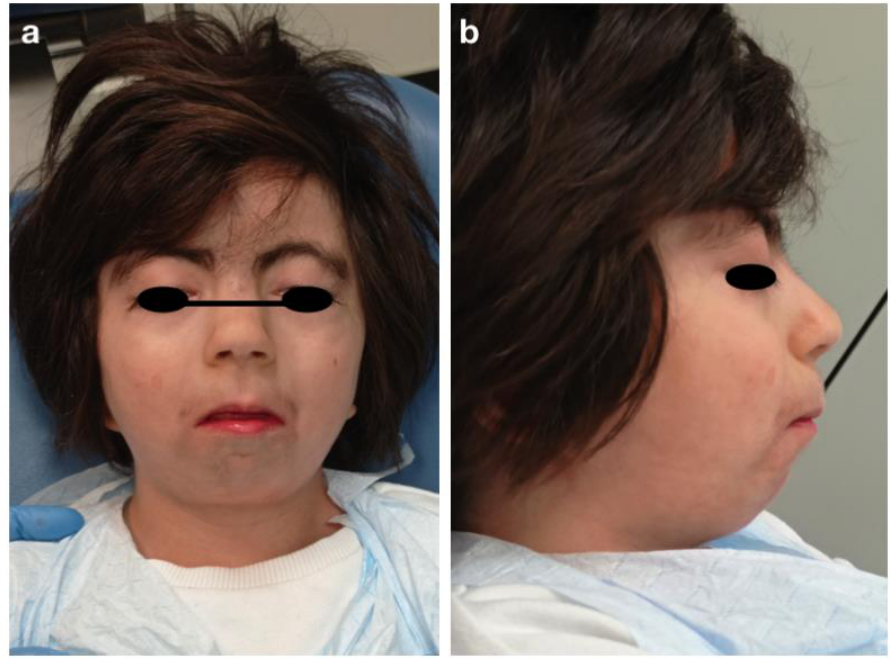
Figure 5. Cornelia de Lange syndrome: extra-oral pictures ( a , b ).